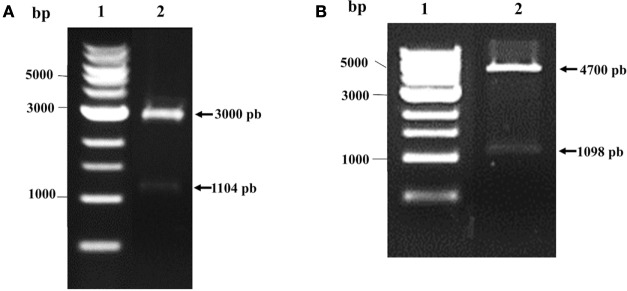
Verification of pV-MEB DNA vaccine and pQE80L-MEB plasmids. (A) Restriction analysis of pV-MEB plasmid digested with BamHI and PstI (line 1) (B) Restriction analysis of pQE80L-MEB plasmid digested with BamHI and PstI (line 1). LM, DNA size marker (1 kb DNA ladder).